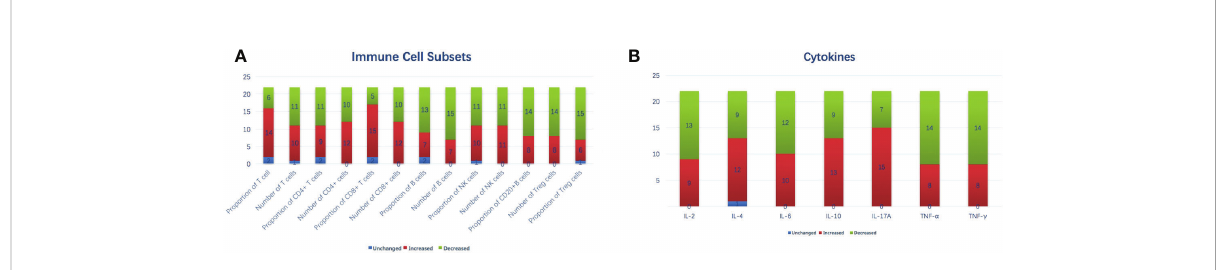
FIGURE 2 Variations in immune cell subsets (A) and cytokines (B) after MWA on a per-patient basis. IL, interleukin; MWA, percutaneous microwave ablation; NK, natural killer; TNF, tumor necrosis factor.